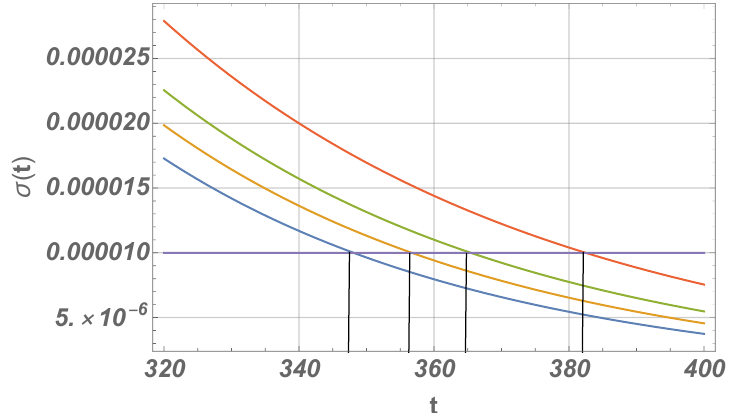
Figure 7 . The (cid:27) ( t ) trajectories cross and thus the (cid:27) ( t ) corresponding to faster rates go to zero earlier.